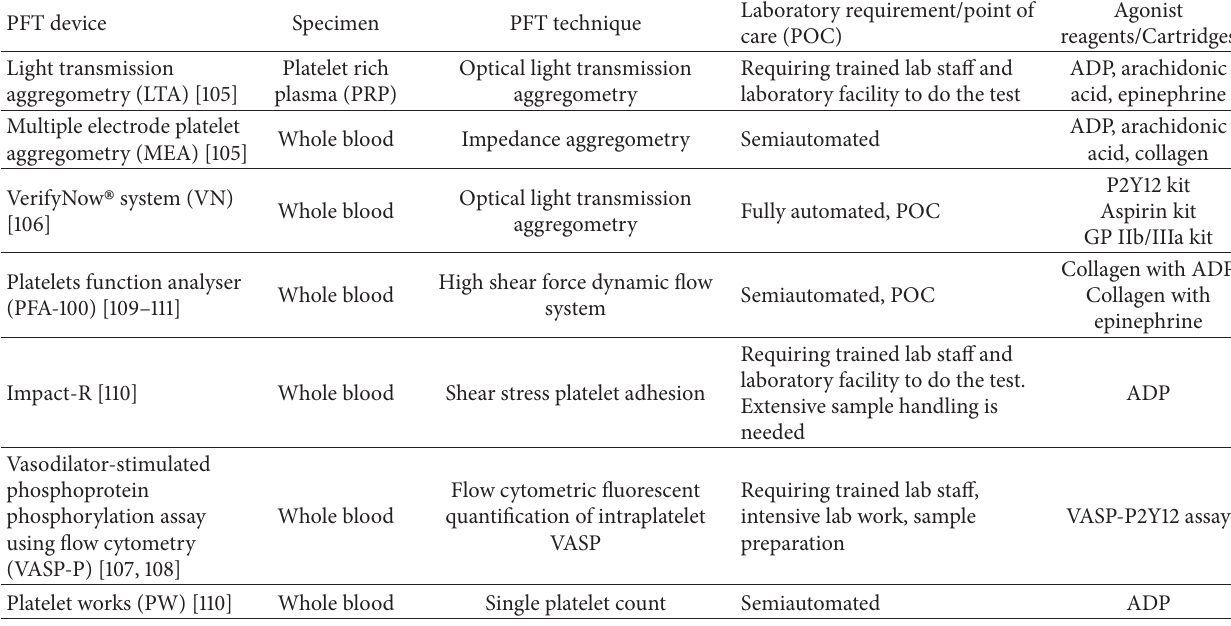
Table 2: Platelets function testing